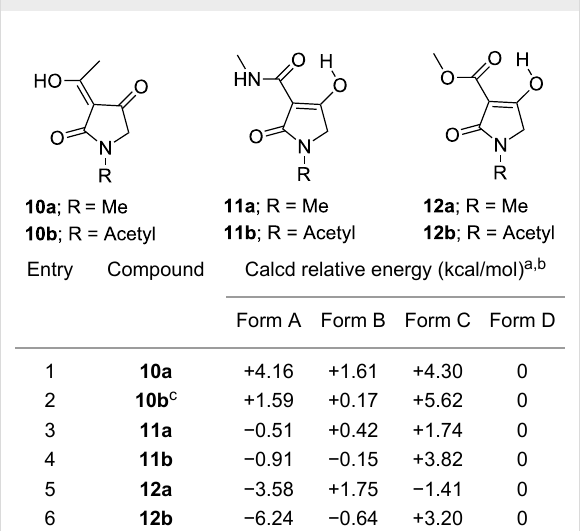
Table 1: Calculated energy of the ground state of 3-acyltetramic acids 10a , b , 3-carboxamide tetramic acids 11a , b and 3-alkoxycarbonyl tetramic acids 12a , b